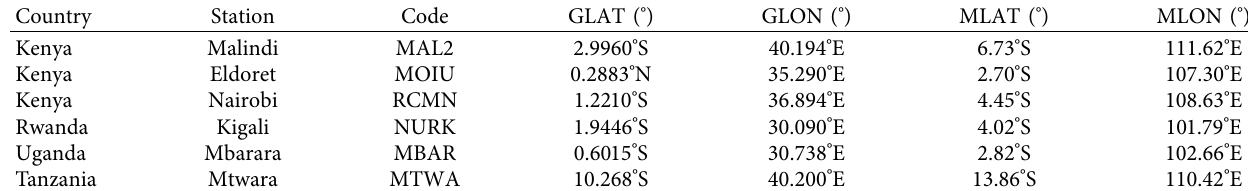
Table 1: Geophysical parameters of the dual frequency GNSS receiver stations.